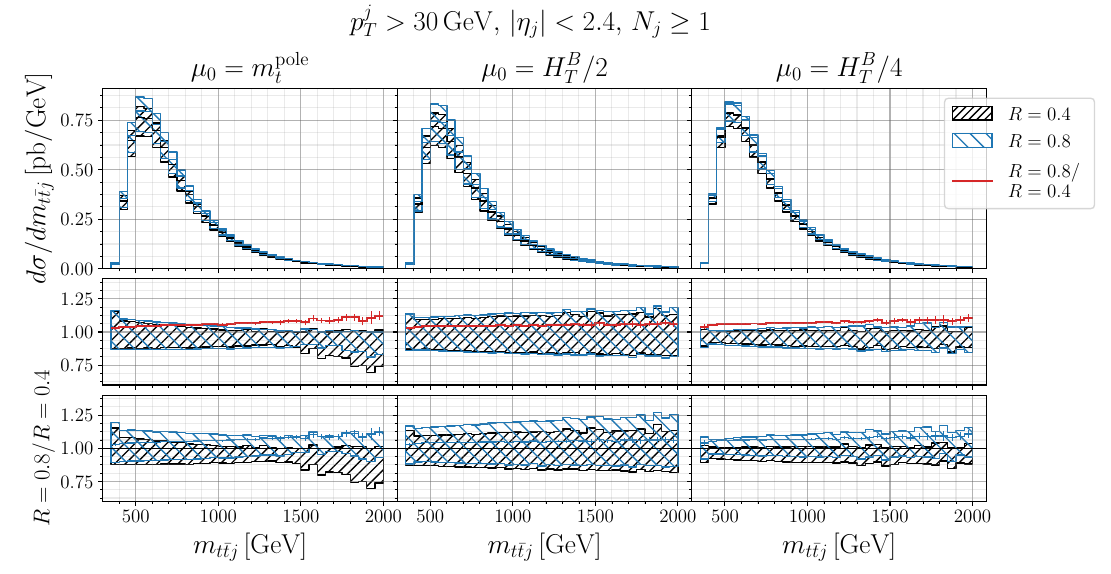
Figure 28 . Same as figure 27, but for the m